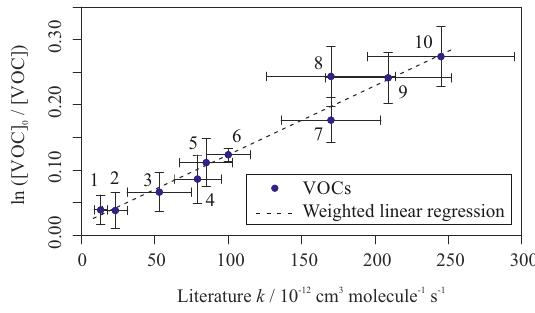
Figure 4. Relative rate plot for Mixture 1 (OH reactivity is 50s − 1 ) at 295K. Compounds with a known rate coefficient are plotted us- ing literature values. Error bars on the y axis, equal to 1 standard error, are calculated by combining the standard error in peak ar- eas for six lamp-off samples and six lamp-on samples. Error bars on the x axis are not displayed for reasons of clarity but are typ- ically large (approximately ± 20–30%) and account for deviations from the line. The black dashed line shows the relationship observed when VOC concentrations are low, modelled by a three-parameter exponential curve (see the Supplement). Identities of VOCs: 1, o - xylene; 2, m -xylene; 3, α -pinene; 4, β -pinene; 5, 3-carene; 6, iso- prene; 7, limonene; 8, γ -terpinene; 9, myrcene; 10, β -ocimene.